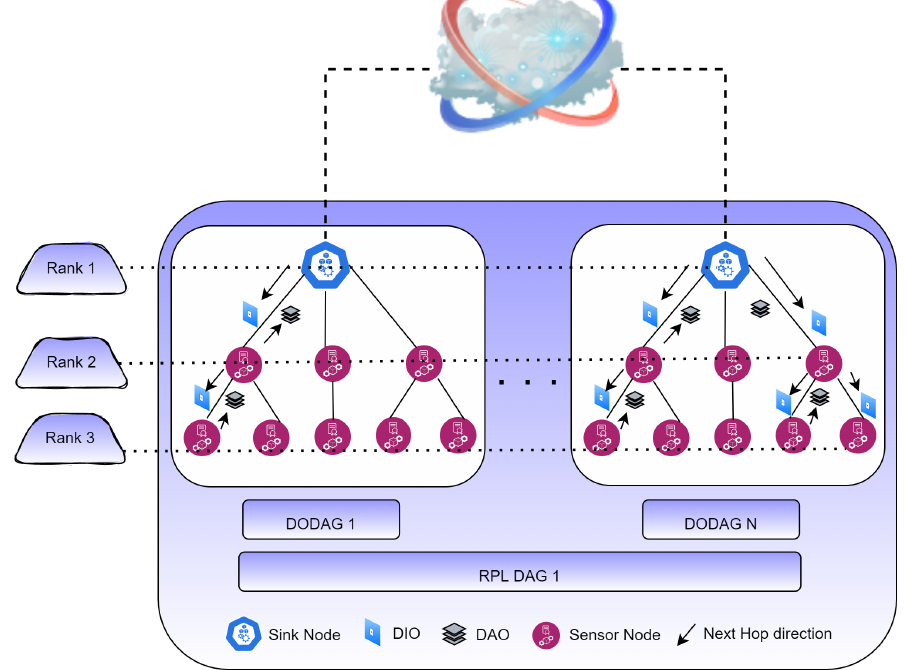
Figure 2. Topology discovery in